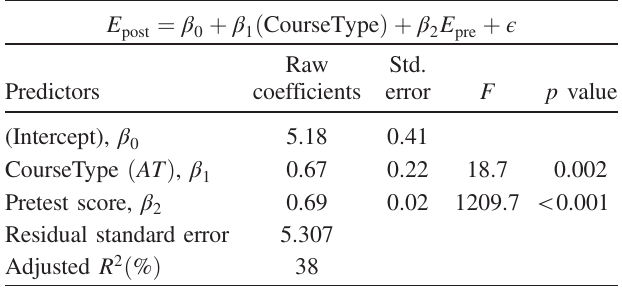
TABLE VI. Results of linear regression (ANCOVA) for men ’ s post-test scores while controlling for pretest